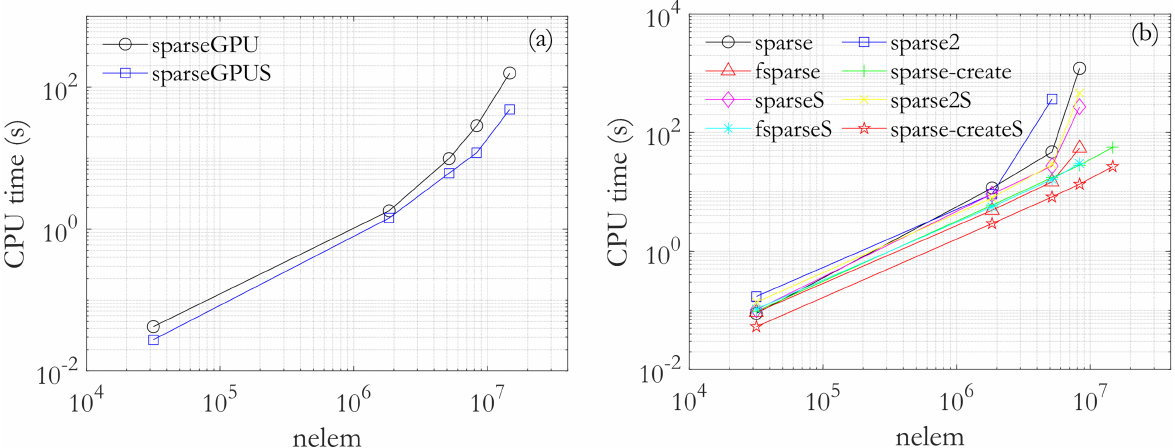
Figure 11. KG global stiffness matrix build time: (a) on GPU and (b) on